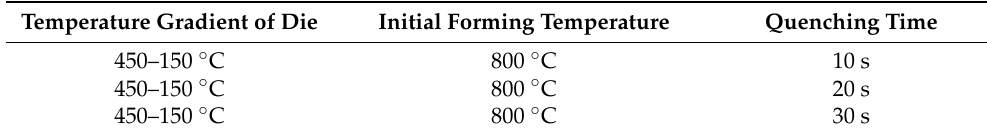
Table 2. Experiment scheme of BR1500HS in the hot stamping.